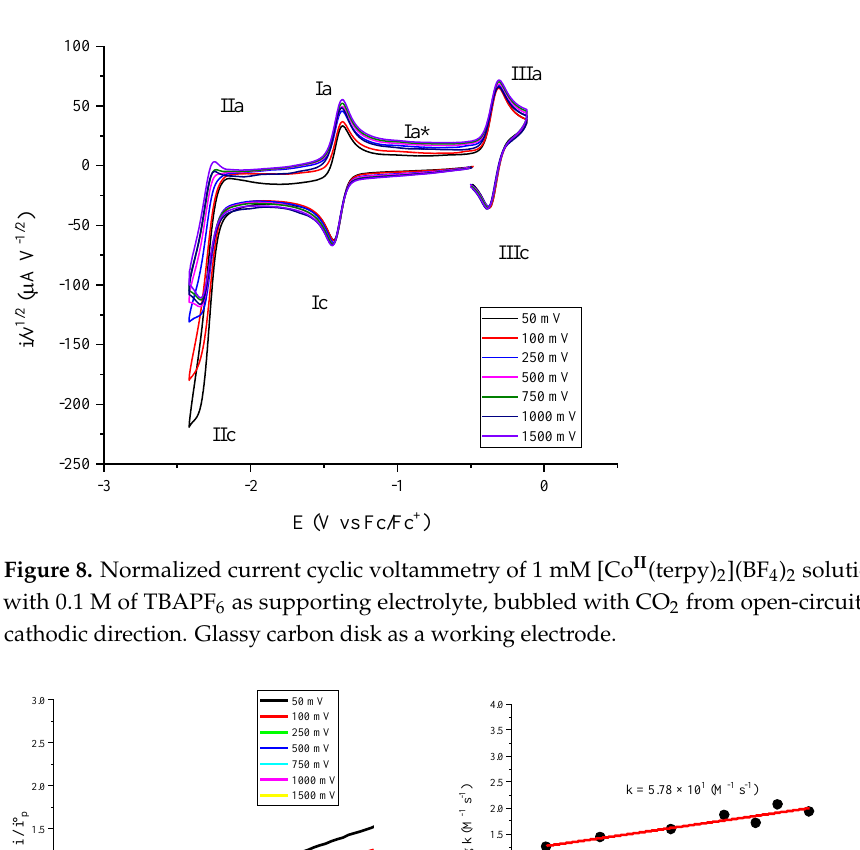
Figure 7. Normalized current cyclic voltammetry of 1 mM [Co II (terpy) 2 ](BF 4 ) 2 solution in MeCN with 0.1 M of TBAPF 6 as supporting electrolyte, bubbled with N 2 (black line) and CO 2 (red line) obtained from open-circuit potential to cathodic direction. Glassy carbon disk as a working elec- trode.